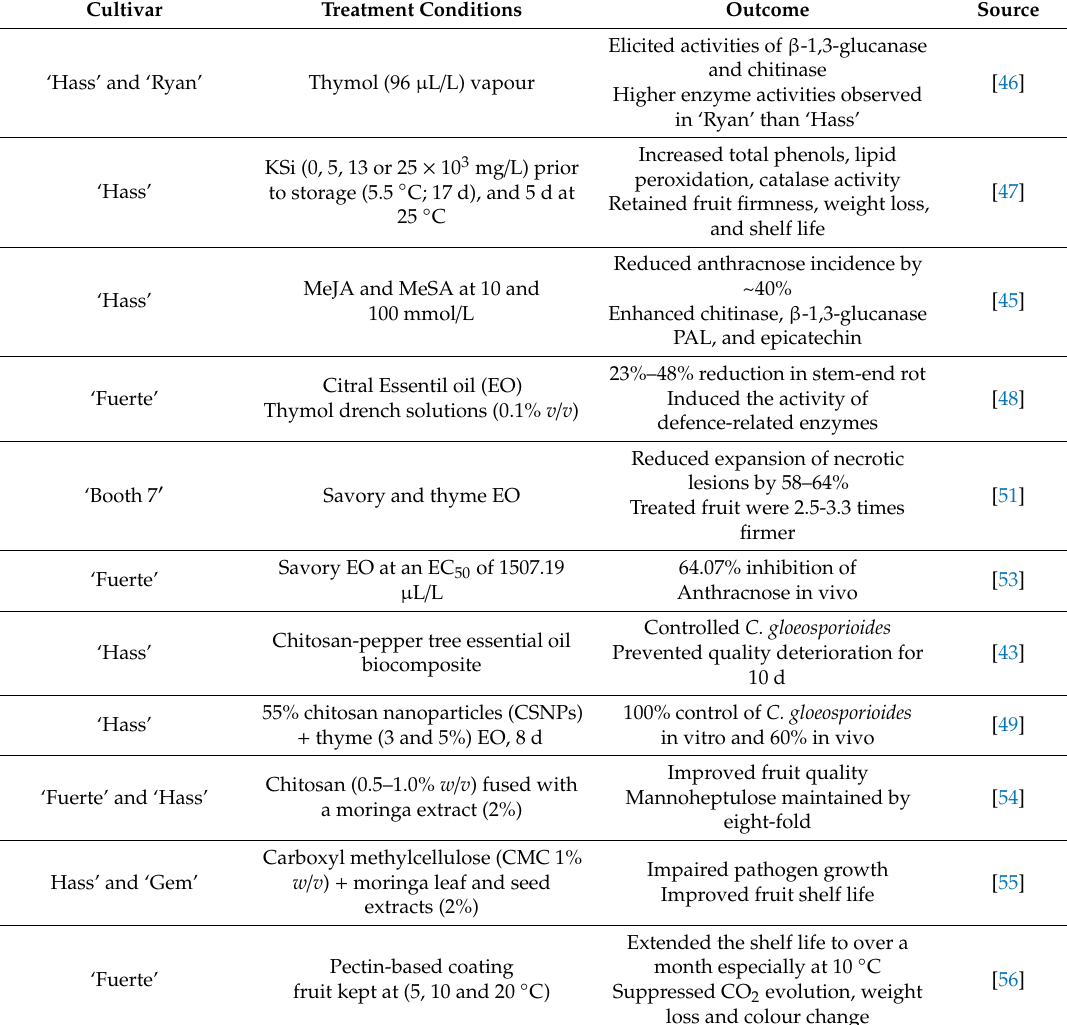
Table 3. Alleviation of postharvest diseases of avocadoes using essential oils-based emulsions.